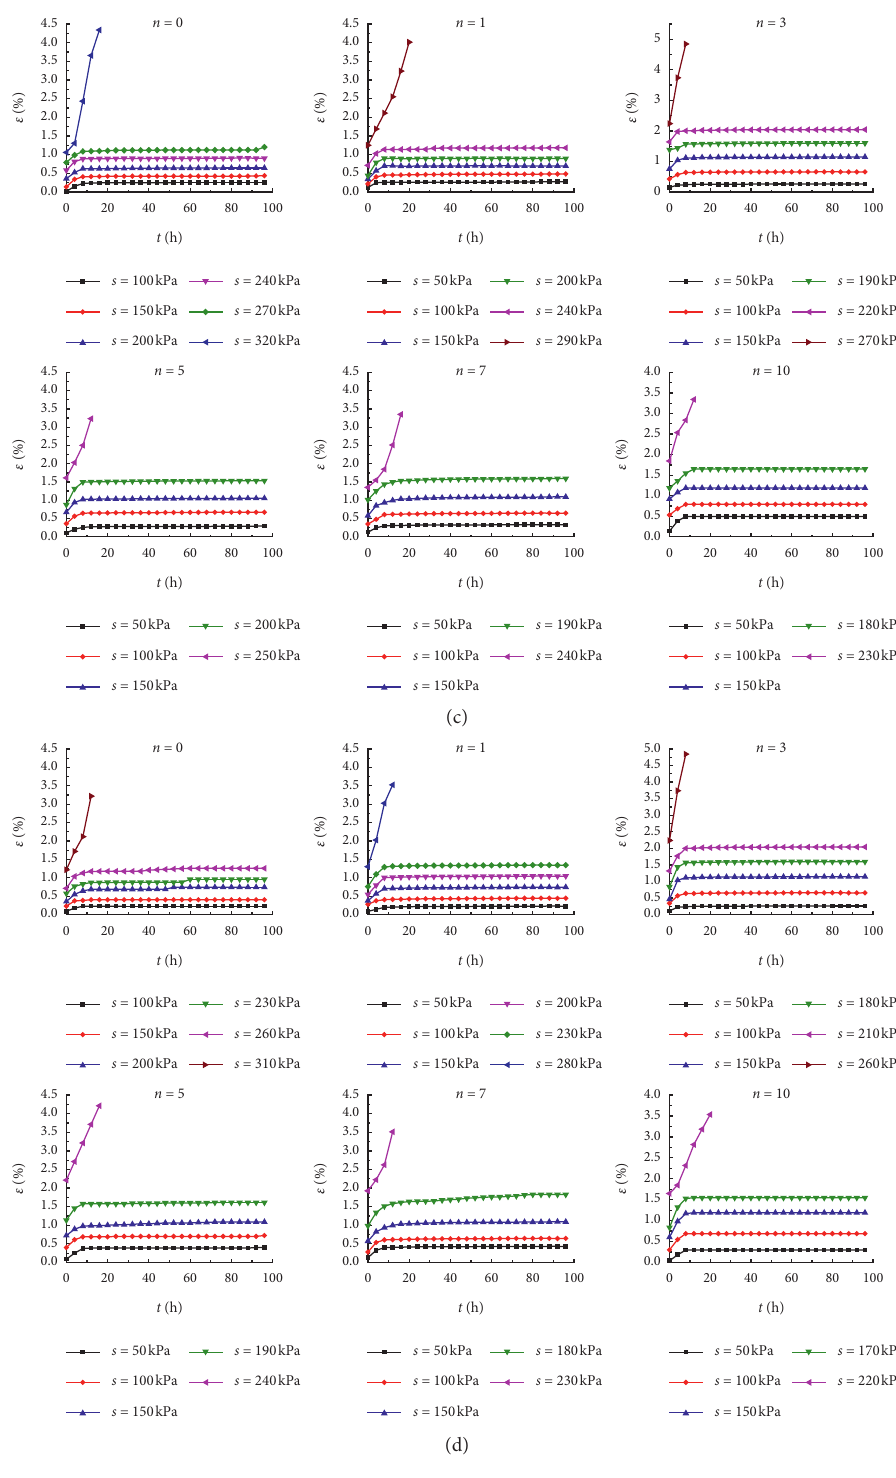
Figure 5: Duration curves of creep. (a) q � 0 kPa, (b) q � 10kPa, (c) q � 15kPa, and (d) q �